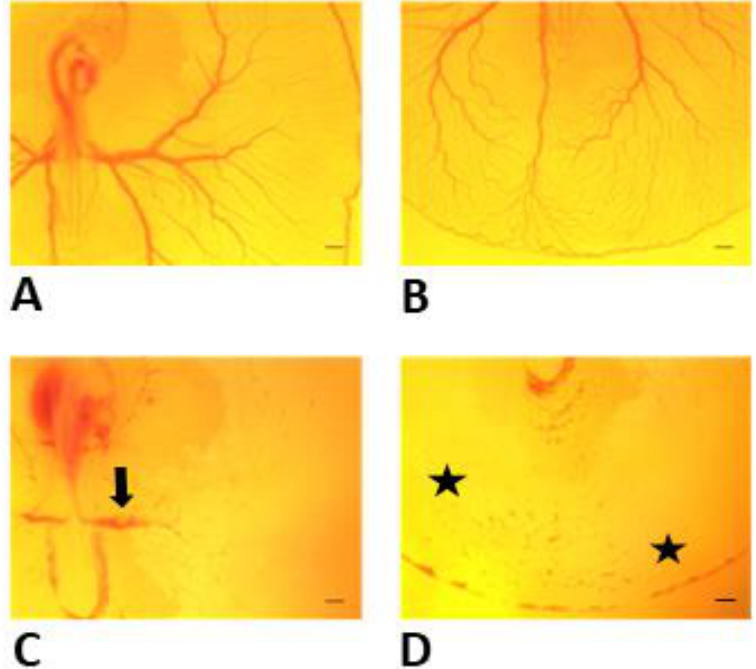
Figure 3. Development of extra-embryonic vasculature of control embryo ( A , B ) and Y-27632 (500 µM)-treated embryo ( C , D ) at 8 h following treatment at 60 h. In the experimental group, the majority of embryos revealed improper formation of omphalomesenteric vessels ( C , arrow) and vitelline vessels in the tail region ( D , asterisks) when compared with controls ( A , B ). Scale bars 200 µm.